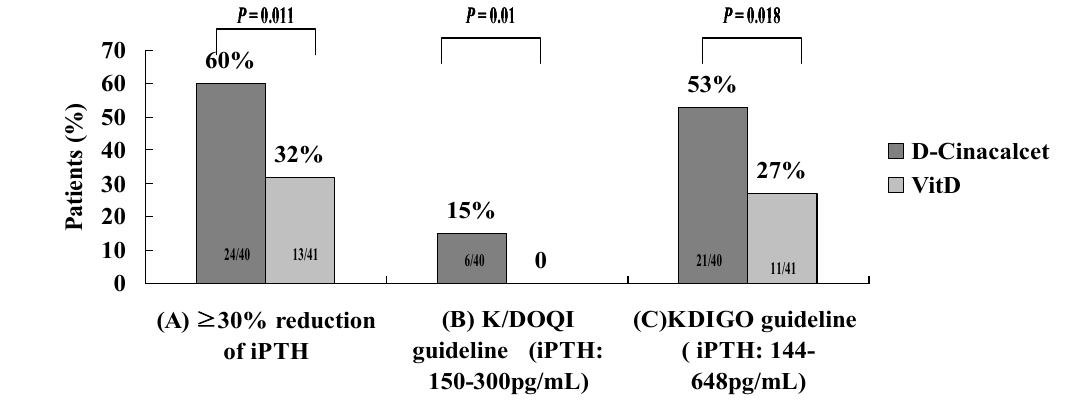
Figure 2. Proportion of patients with ( A ) ≥30% reduction of iPTH from baseline, ( B ) achieving treatment target of iPTH recommended by the Kidney Disease Outcomes Quality Initiative (K/DOQI) and, ( C ) by Kidney Disease: Improving Global Outcomes (KDIGO) after 6 months of